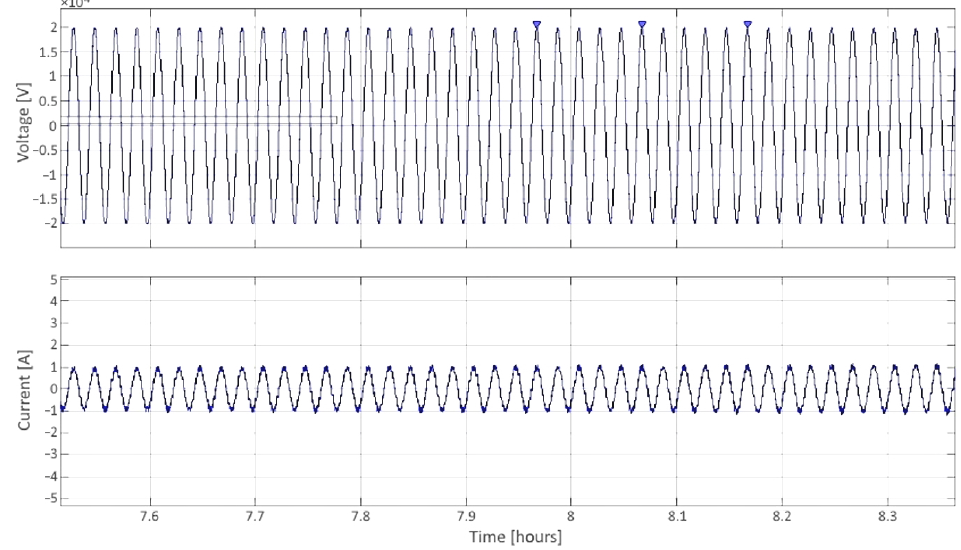
Figure 27. Approximation of the waveforms of voltage and current in the network, phase A, on a sample day in July day between 7:30 a.m. and 8:30 a.m. Table 5. Maximum and minimum values of current and voltage of the power system.